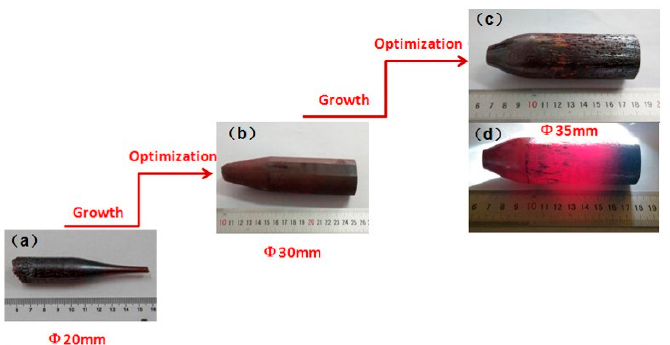
Figure 2. The AGGSe crystals with dimensions of ( a ) Φ 20 mm, ( b ) Φ 30 mm, ( c ) Φ 35 mm and ( d ) Φ 35 mm under table lamp light.